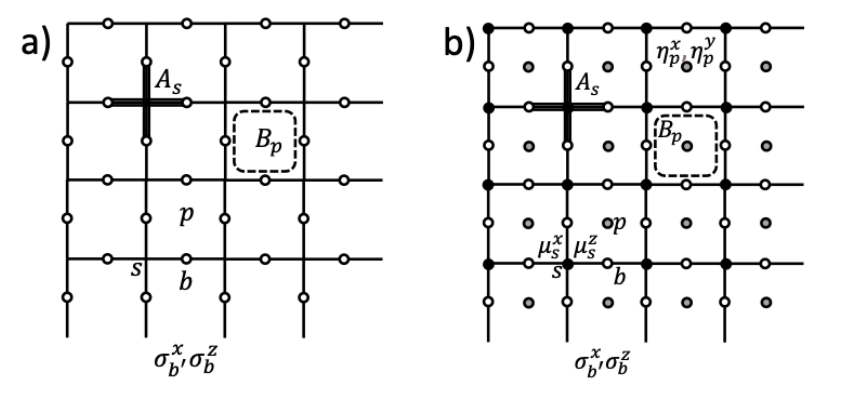
Figure 1: A 2 D square lattice with periodic boundary conditions. a) Labels for lattice sites s , bonds b and plaquettes p are shown, as well as spins involved in site operators ˆ A and plaquette operators ˆ B . b) Redundant 1 / 2 spin degrees of freedom ˆ (cid:126)µ s p ˆ (cid:126)η introduced at the sites s and center of plaquettes face p are shown. We p